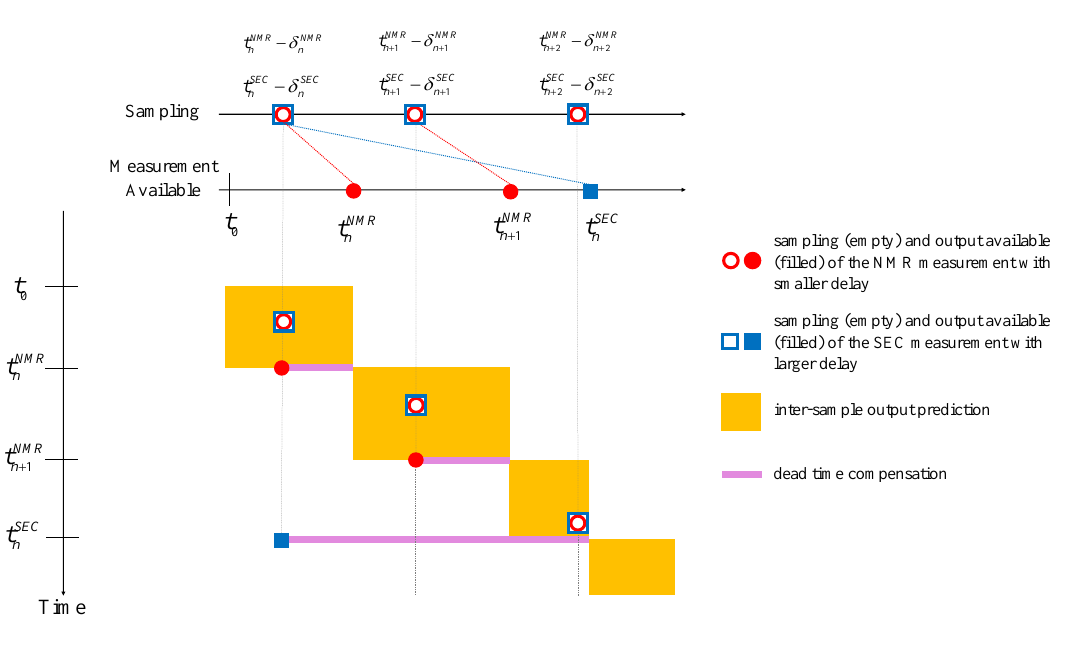
Figure 1. An illustration of the two-step estimation process of a multi-rate multi-delay observer for the RAFT polymerization process starting from t 0